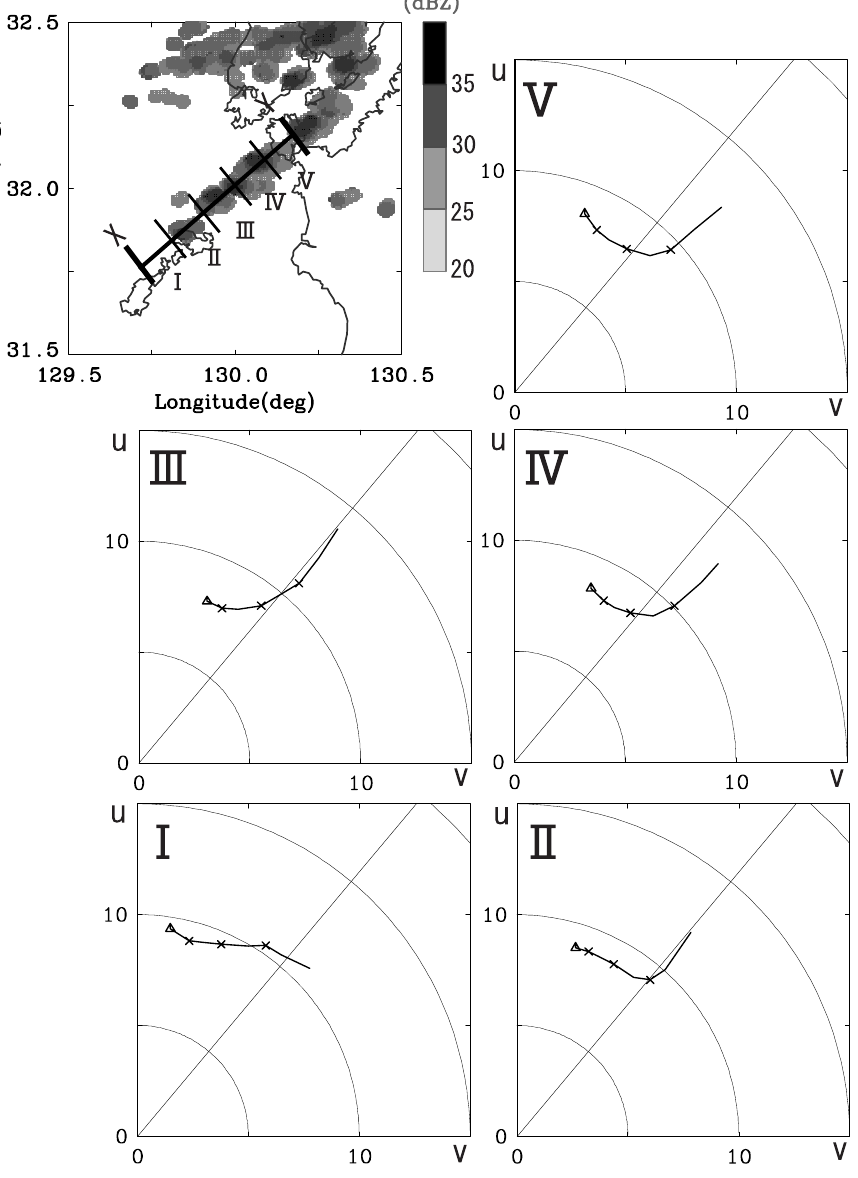
Fig. 11. Doppler radar at 12:20 JST on 1 July 2002 and hodographs of horizontal wind averaged from 11:00 to 13:00 JST on 1 July at regions 1,2,3,4,5. Triangles ( 4 ) indicate surface, and crosses ( × ) are put on the curve at 1km height